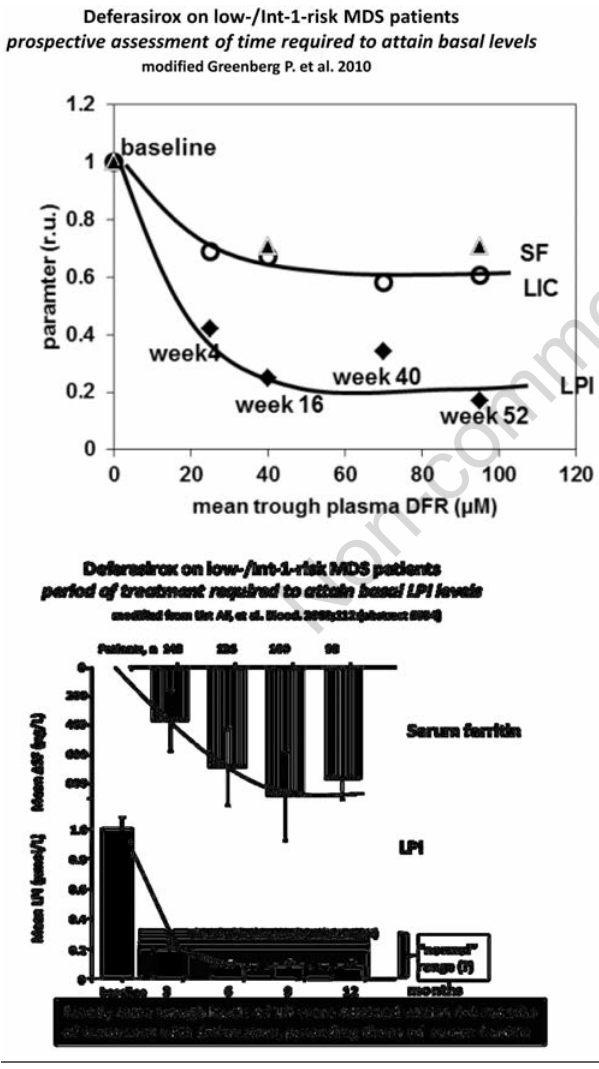
Figure 8. LPI in MDS patients treated with different chelators (compiled from Ref. 15 and